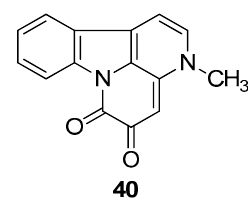
Figure 3. Structure of canthine 40 .